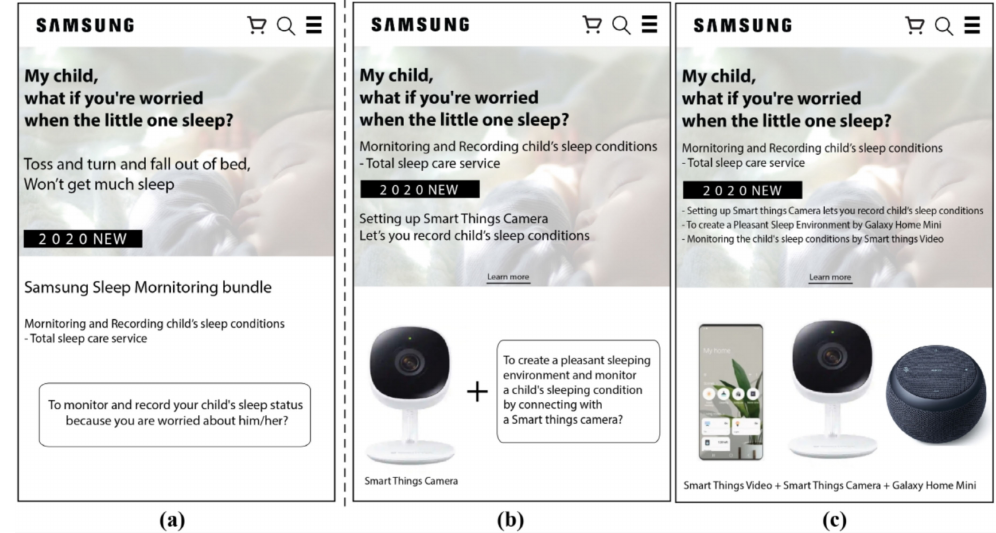
Figure 1. Study 1 stimuli ( a ) before information seeking; ( b , c ) after information